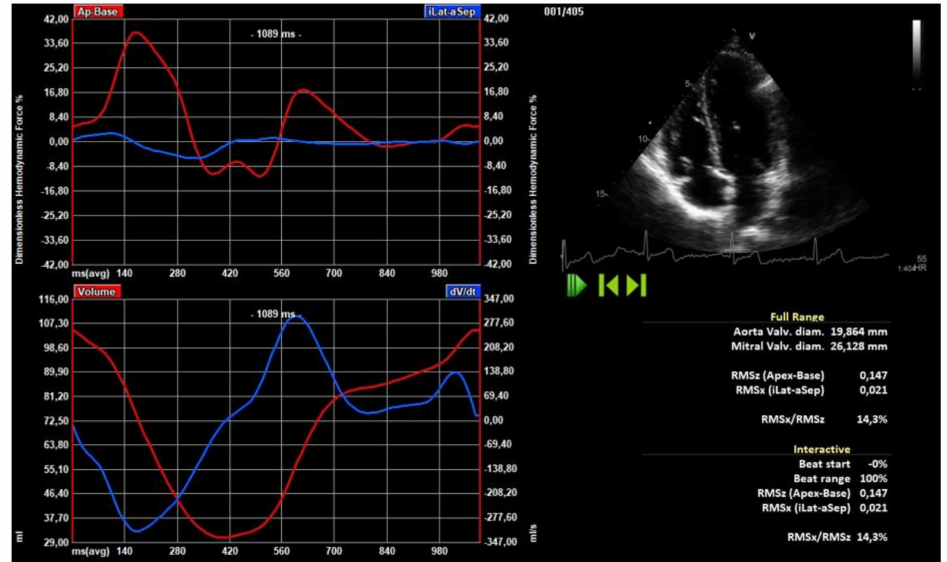
Figure 3. Representation of dimensionless hemodynamic forces obtained by speckle tracking